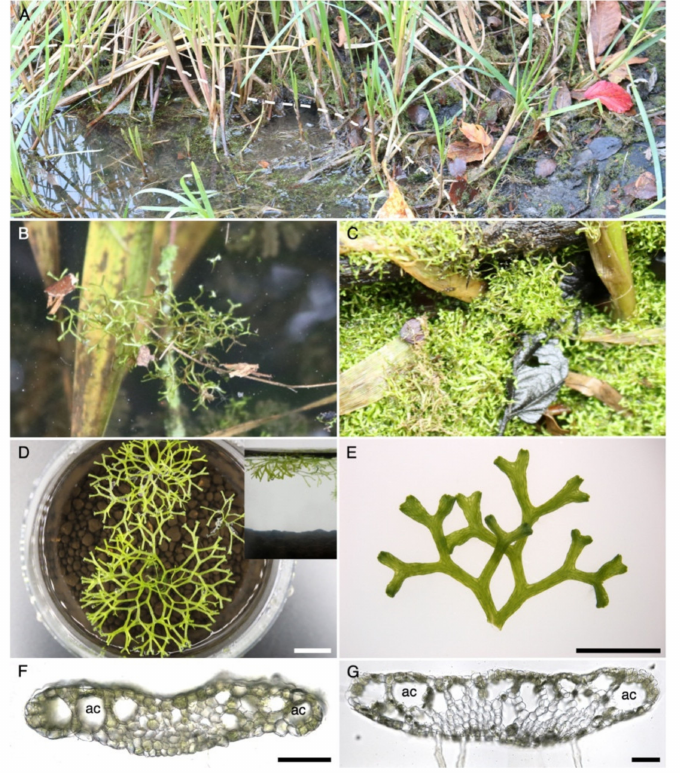
Figure 6. R. fluitans BoGa ecotype. ( A ) R. fluitans BoGa in its natural habitat, a waterside of the main pond in the Botanical Garden of Osnabrück. White dashed line indicates the water to land border. ( B ) Floating WF thalli of R. fluitans BoGa. ( C ) LF forms dense mats close to the littoral zone. ( D ) Top view of a WF culture, where inset shows a side view of the floating culture. ( E ) LF grown in axenic culture. Thallus cross section with air chambers (ac) of the WF ( F ) and LF ( G ). Scale bars D: 1 cm; E: 5 mm; F, G: 100 µ